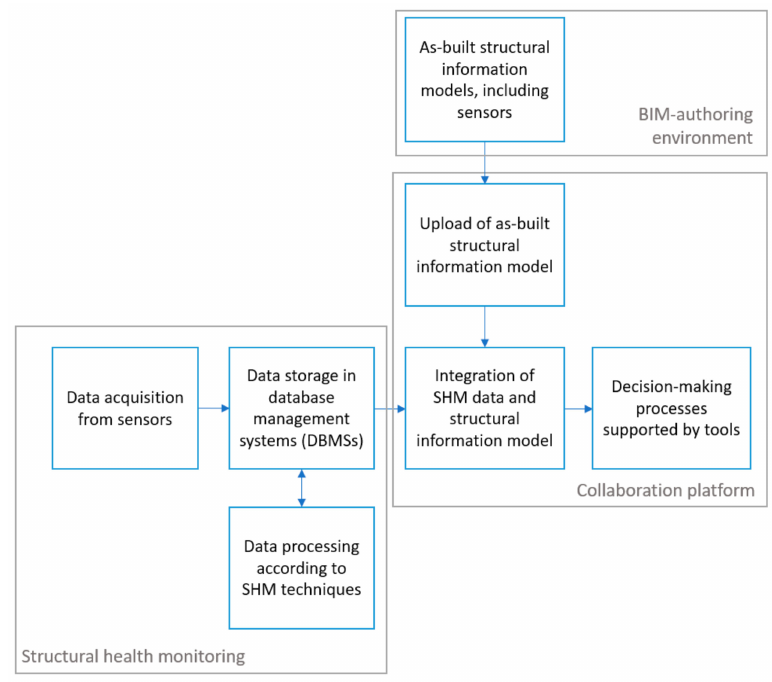
Figure 11. Example of reference framework for BIM use